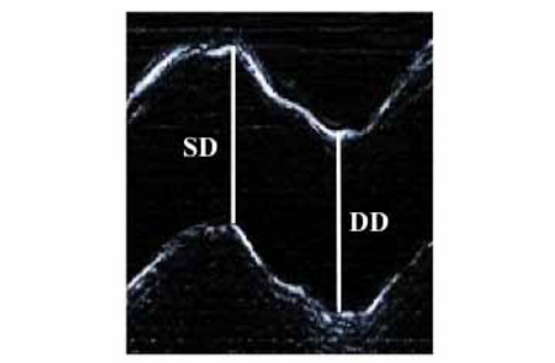
Figure 1. Measurement of systolic (DS) and diastolic (DD) ascending aortic diameter is presented on an M-mode echocardiographic image obtained at a level 3 cm above the aortic valve (Figure 1A).